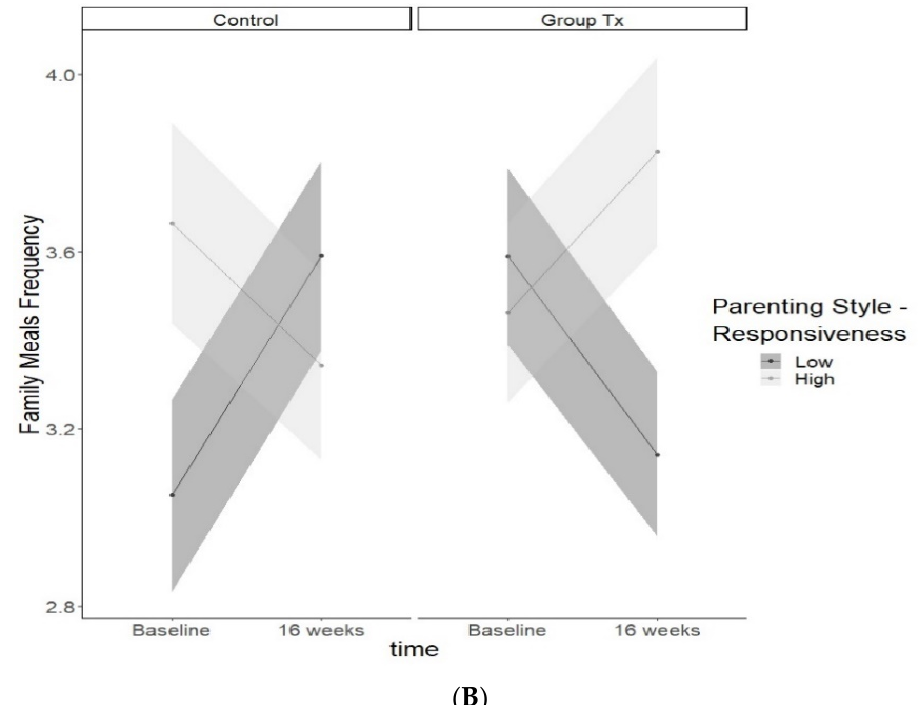
Figure 1. Three-way interaction between time x group treatment x demandingness ( A ) and time x group treatment x responsiveness ( B ) predicting frequency of family meals.